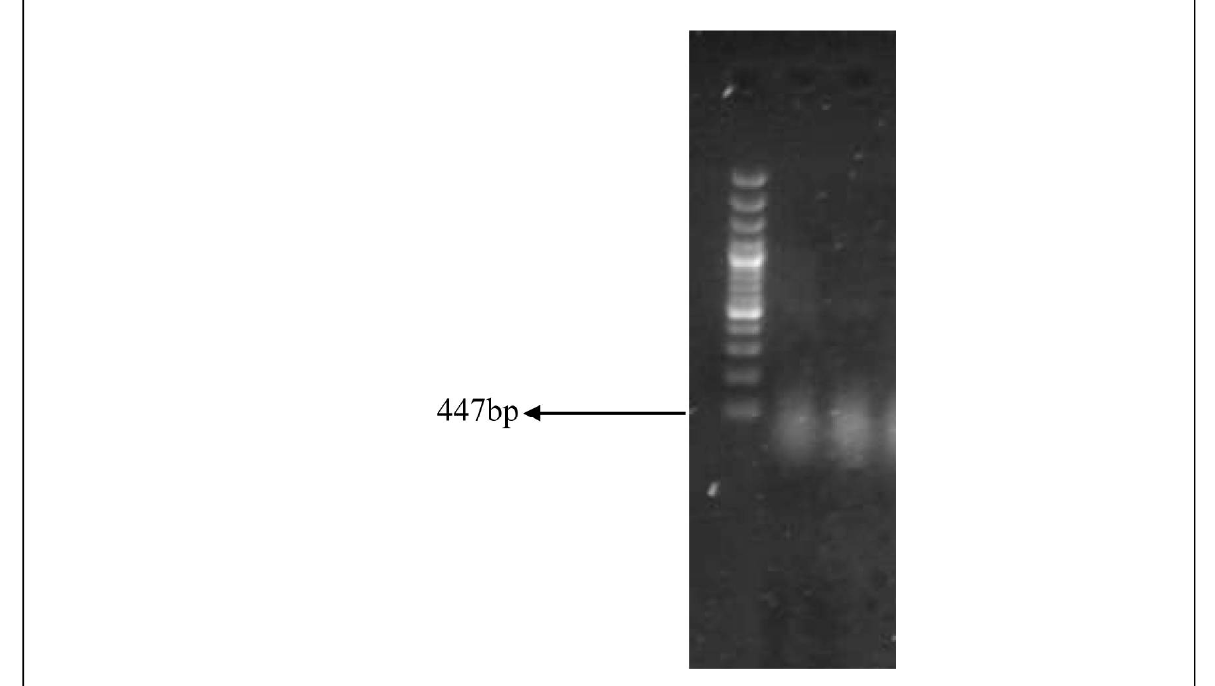
Figure 1: Isolates possessing aadA gene confirming resistance to